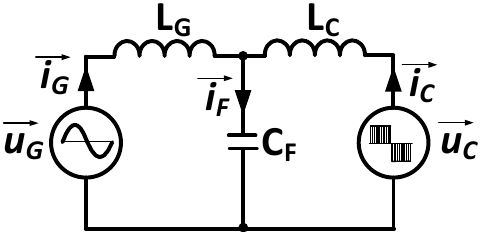
Fig. 4. Single-phase equivalent circuit of the VSC with LCL